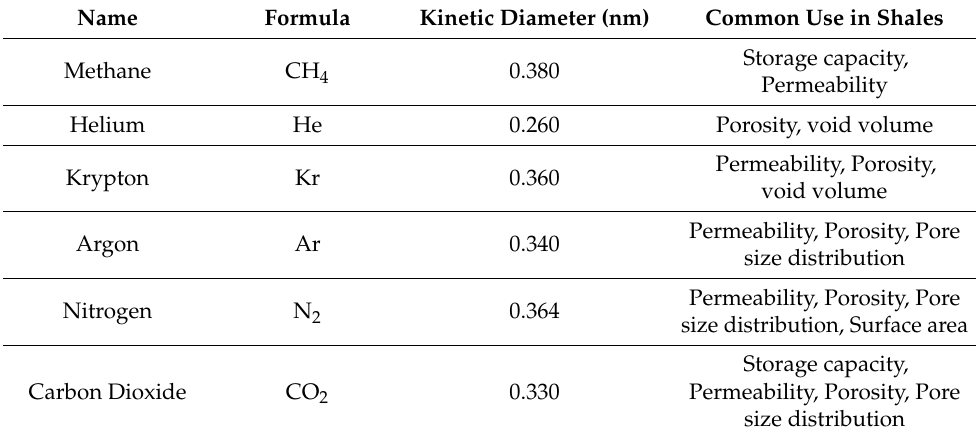
Table 1. Gases used for shale